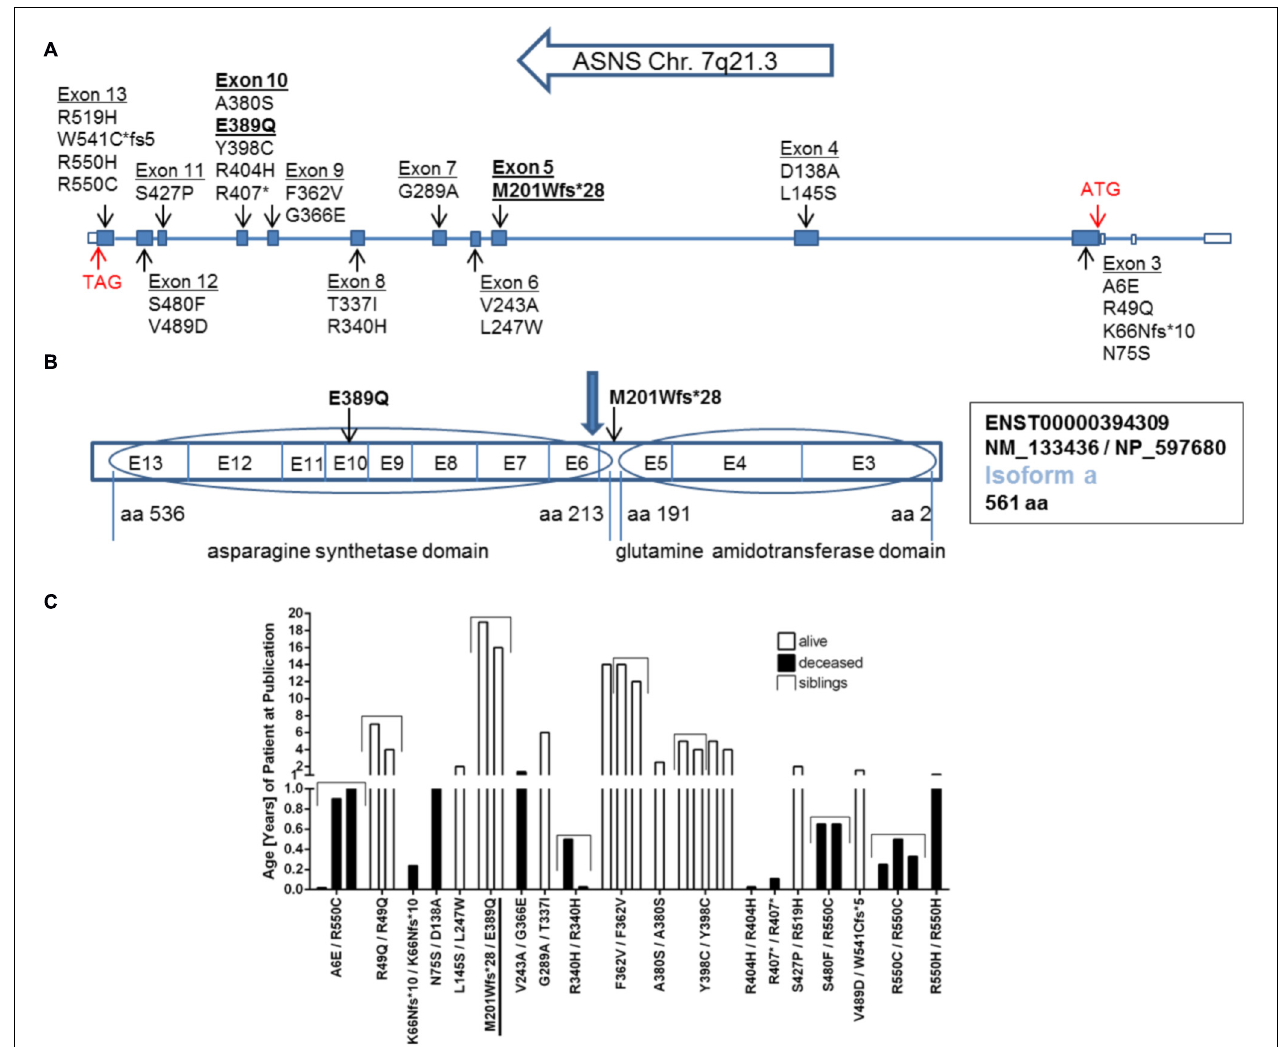
FIGURE 2 | Mutations in the ASNS gene. (A) Schematic representation of the gene structure of ASNS including the location of mutations so far described for ASNS deficiency in the literature and the newly identified mutations in bold . Filled boxes indicate translated exons. The translation start site (ATG) is located in exon 3, the stop codon (TAG) in exon 13 ( red arrows ) referring to transcripts for isoform a. (B) Exons coding for the glutamine amidotransferase domain and the asparagine synthetase domain in the protein. The mutation M201Wfs ∗ 28 is located between both domains and the blue arrow indicates the position of the stop codon generated by the M201Wfs ∗ 28 mutation. The mutation E389Q is located in exon 10. E-exon, aa-amino acid. (C) Survival of children born alive and with confirmed homozygous or compound heterozygous mutations in ASNS. Given is the age in years as reported in the patient description at the time point of the initial publication or the follow up study. The compound heterozygous mutation M201Wfs ∗ 28/E389Q presented here is underlined . See Table 1 for references regarding the other